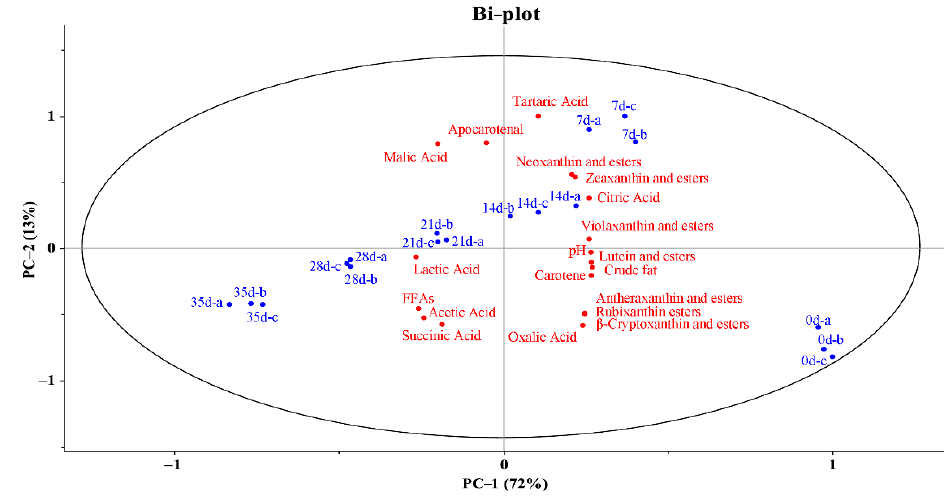
Figure 4. PCA analysis of fermented yellow lantern pepper sauce samples. The red letters represented physiochemical indices; the blue letters represented different carotenoids. respectively.